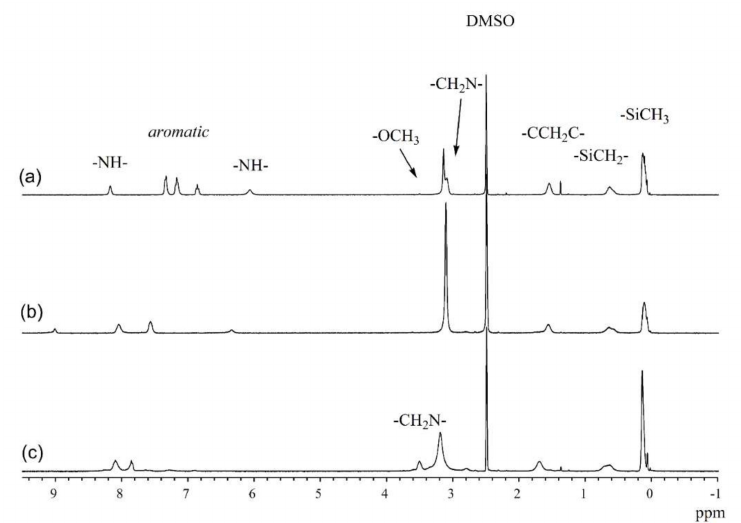
Figure 1. 1 H NMR spectra of ( a ) PSO 1a(0.1) -TMS (Table 1, run 1), ( b ) PSO 1b(0.1) -TMS (run 4), and ( c )